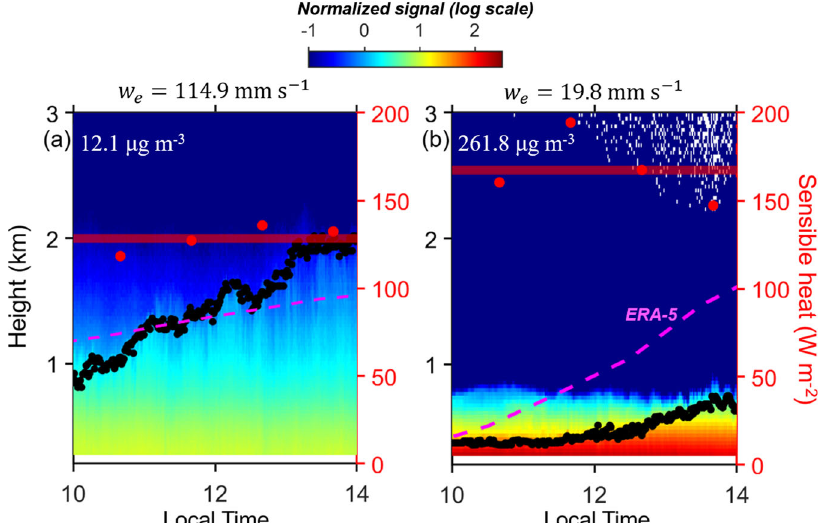
Fig. 1 PBL evolution during the growth period. Lidar backscatter pro fi les for a the clean case (date: 21 August 2019) and b the polluted case (date: 1 April 2018) during the growth period over Beijing, China. Backscatter is presented as a normalized signal on a log-scale, in arbitrary units. Black dots mark the positions of the PBL top. Red dots and red lines indicate the corresponding measurements of sensible heat and the mean value, respectively. Pink dash lines indicate variations in the PBLH obtained from ERA-5 reanalysis data. The mean values of PM 2.5 during these periods are given in each panel. The mean values of observed entrainment rates ( w e ) are presented at the top of each panel. Hereafter, we use millimeter per second as the unit for the entrainment rate (1 mm s − 1 = 10 − 3 m s − 1 ).